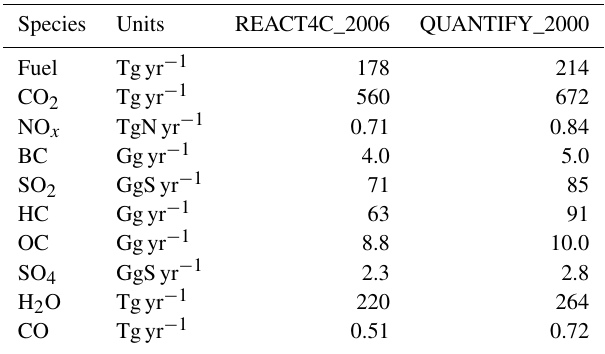
Table 1. Total global aircraft emissions corresponding to the base- line REACT4C_2006 and QUANTIFY_2000